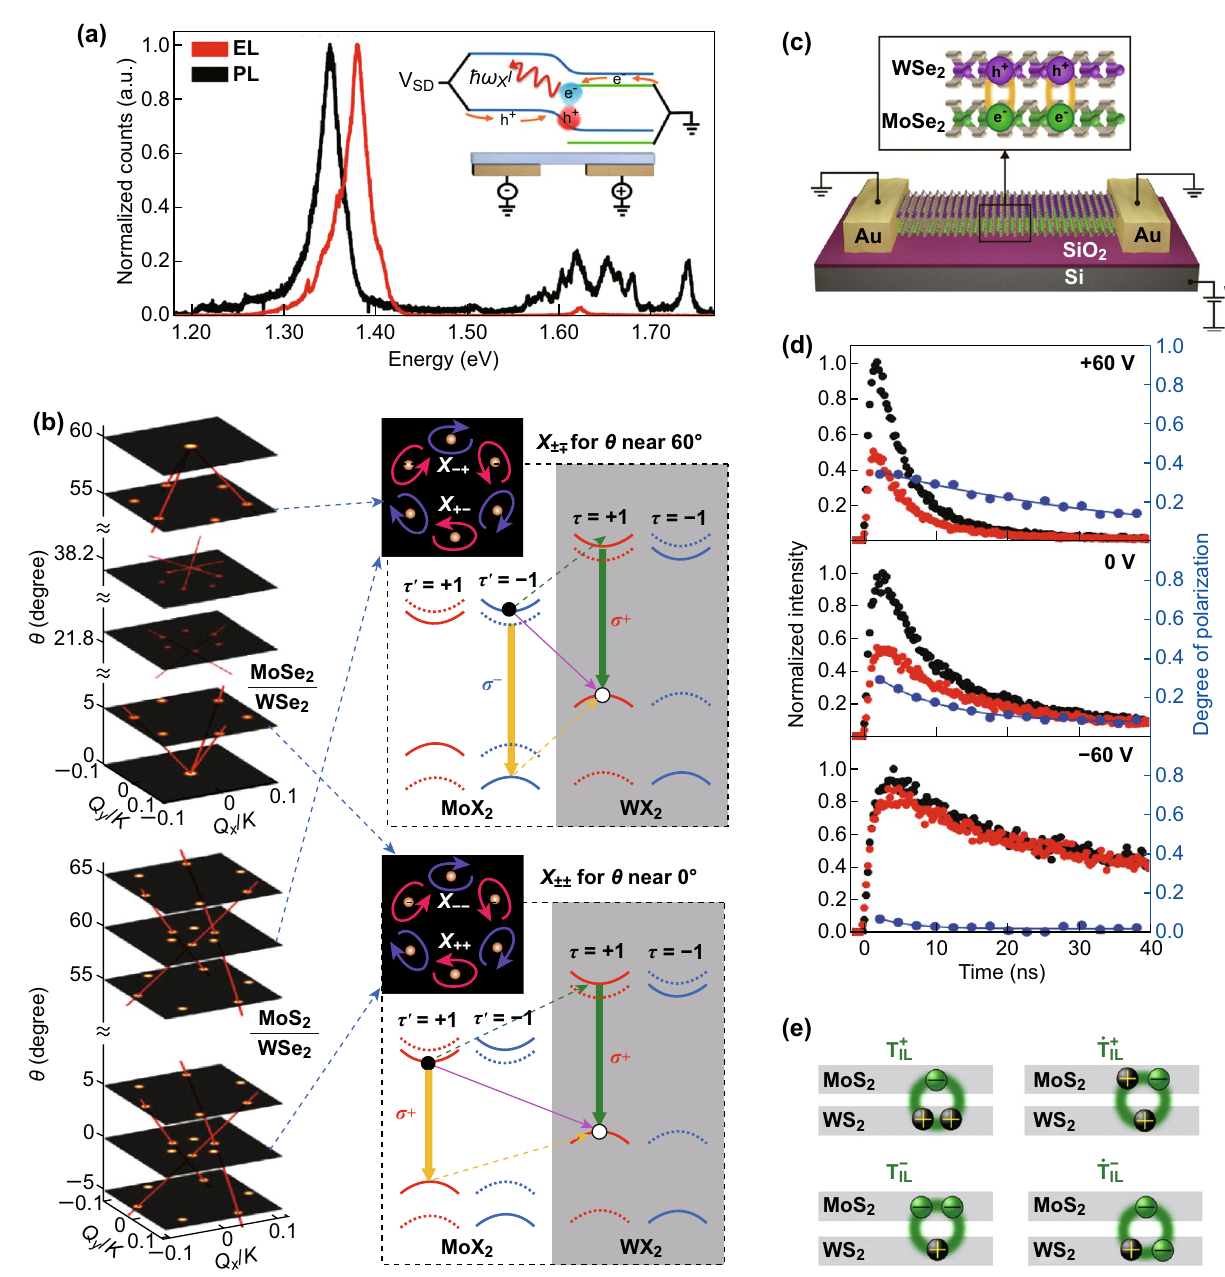
Fig. 6 The properties of excitons in 2D heterostructures. a EL spectra of the MoSe 2 /WSe 2 vertical heterostructure, a small intralayer signal at 1.62 eV was detected, and the inset illustrates the device structure. (Blue and green lines represent the WSe 2 and MoSe 2 , respectively.) Reprinted with permission from Ref. [66]. b The optical selection rules in a MoX 2 /WX 2 heterostructure with twist angle θ of 0° and 60°, respectively. Reprinted with permission from Ref. [17]. c , d Time‑resolved PL ( d ) of WSe 2 /MoSe 2 heterostructure ( c ) after σ + pulsed laser excitation, black dots and red dots corresponding to the co‑polarized emission ( σ +) and cross‑polarized emission ( σ −), and the blue line shows the degree of polarization, which is tunable by the gate voltage. Reprinted with permission from Ref. [67]. e The trions composed in different ways existing in the MoS 2 /WS 2 bilayer. Reprinted with permission from Ref. [68]. (Color figure